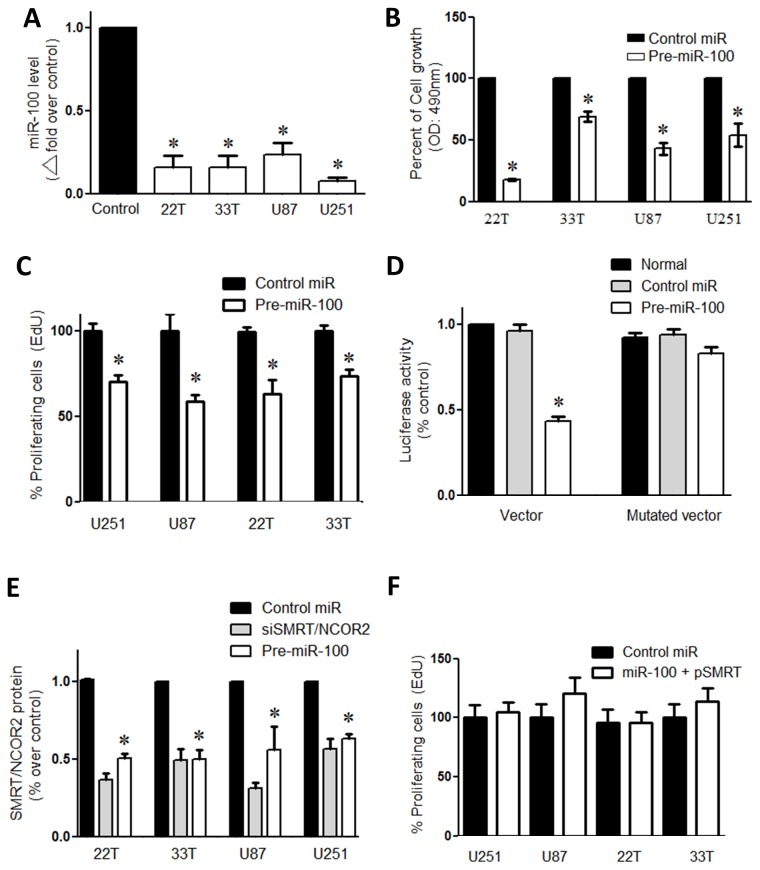
miR-100 decreases GBM proliferation and targets SMRT/NCOR2.(A) Quantitative PCR showed native miR-100 expression in multiple GBM tumor lines relative to normal control (astrocyte extracted from non-tumor brain). All GBM lines showed significantly lower miR-100 expression. (B) miR-100 overexpression decreased GBM cell growth compared to control miR transfected group. Control scrambled miRs did not affect GBM cell growth compared to miR-100. (C) miR-100 overexpression decreased GBM proliferation up to 45% compared to control miR group. (D) Transient luciferase reporter assay with either wild-type or mutated SMRT/NCOR2 3’UTR vectors. Both vectors were co-transfected with pre-miR-100 or control miRs. The normal bar represents transient luciferase reporter expression with no further treatment. (E) Western blot quantitation of SMRT/NCOR2 protein level after miR-100 expression. SMRT/NCOR2 level was reduced by transfection with either pre-miR-100 or SMRT/NCOR2 siRNAs (siSMRT/NCOR2) compared to control miR transfected group. (N=3; p ˂ 0.05). (F) EdU proliferation assay shows miR-100 overexpression along with SMRT overexpression (pSMRT) prevented proliferation inhibition reported in panel (C).